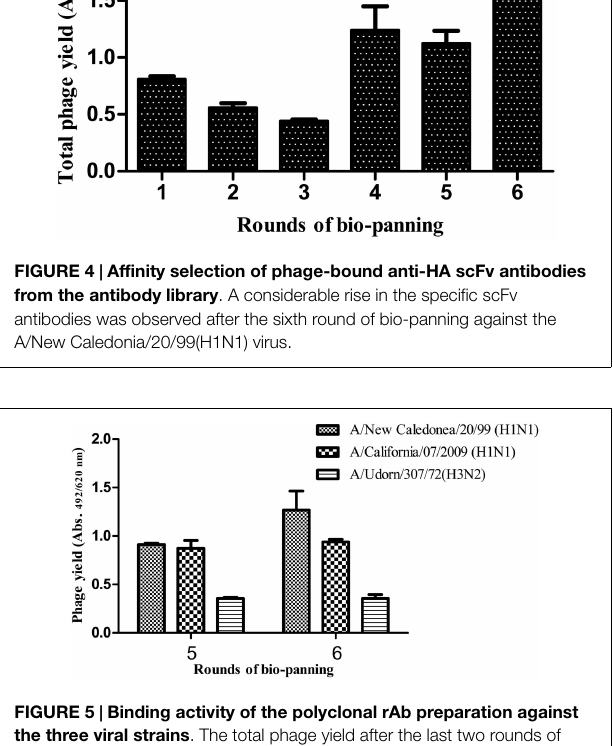
FIGURE 5 | Binding activity of the polyclonal rAb preparation against the three viral strains . The total phage yield after the last two rounds of bio-panning was analyzed against the A/New Caledonia/20/99(H1N1), A/California/07/2009(H1N1)-like and A/Udorn/307/72(H3N2) viruses by ELISA.